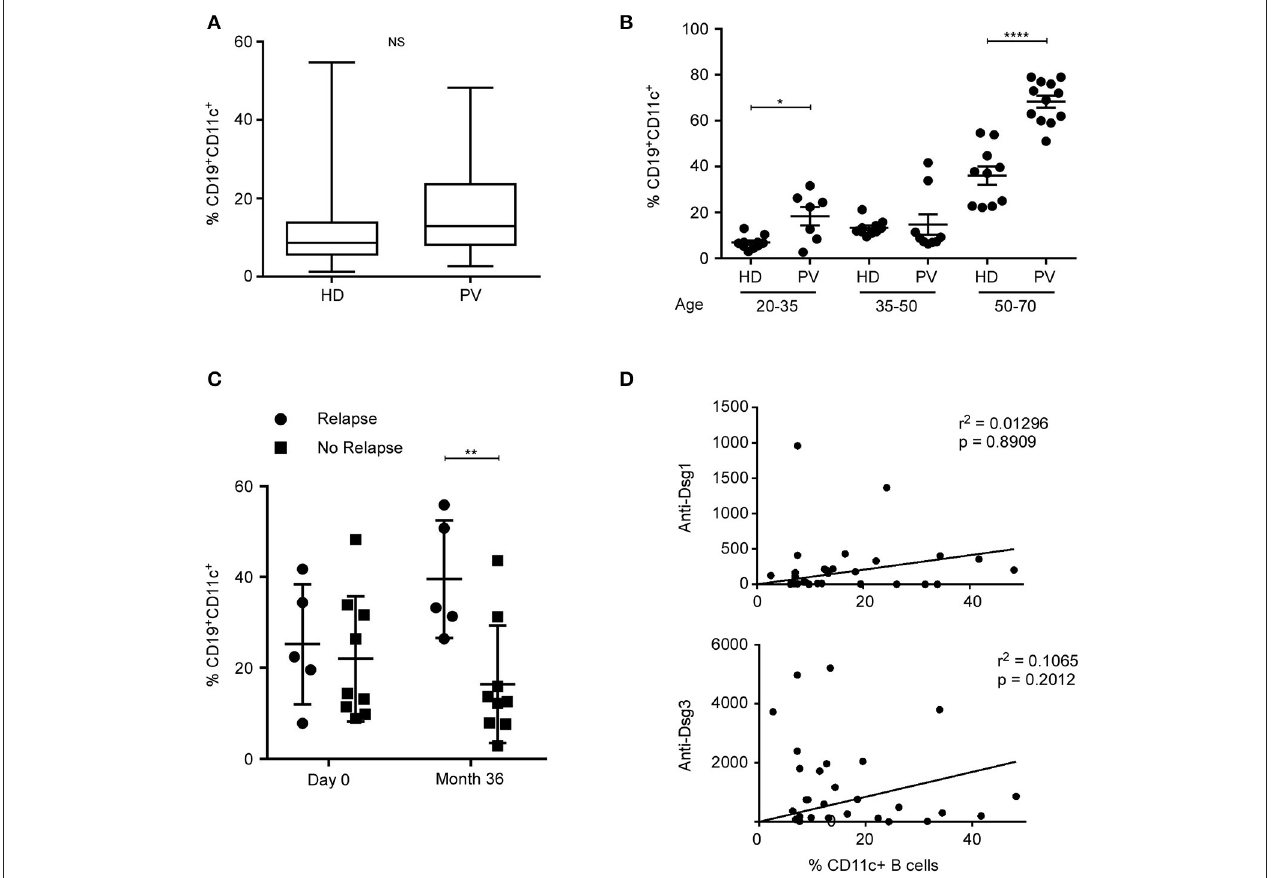
FIGURE 8 | Higher frequency of CD11c + B cells in pemphigus patients with active disease. (A) Box plot of CD11c + CD19 + frequency determined by cytometry in blood of healthy donors (HD) and pemphigus vulgaris (PV) patients. NS, non-significant. CD11c + B cells’ frequencies were measured for 28 patients with PV and 52 HD, independently of their age. There was no significant difference between patients with an active autoimmune disease and a large group of HD. (B) Percentage of CD11c + B cells for HD and PV donors between age 20 and 35, 35 and 50, and 50 and 70 years old were compared. Significant difference is determined by one-way ANOVA with correction by Bonferroni’s multiple comparison test. * p < 0.05, **** p < 0.0001. (C) Percentage of CD11c + CD19 + B cells was measured by flow cytometry in PV patients at day 0 and 36 months after treatment. Patients were grouped according to whether or not they relapsed after treatment. Means were compared by two-way ANOVA with correction by Sidak’s multiple comparison test: ** p < 0.01. (D) Increase in CD11c B cells does not correlate to anti-DSG titer in PV patient blood ( r , Pearson correlation coefficient; n =